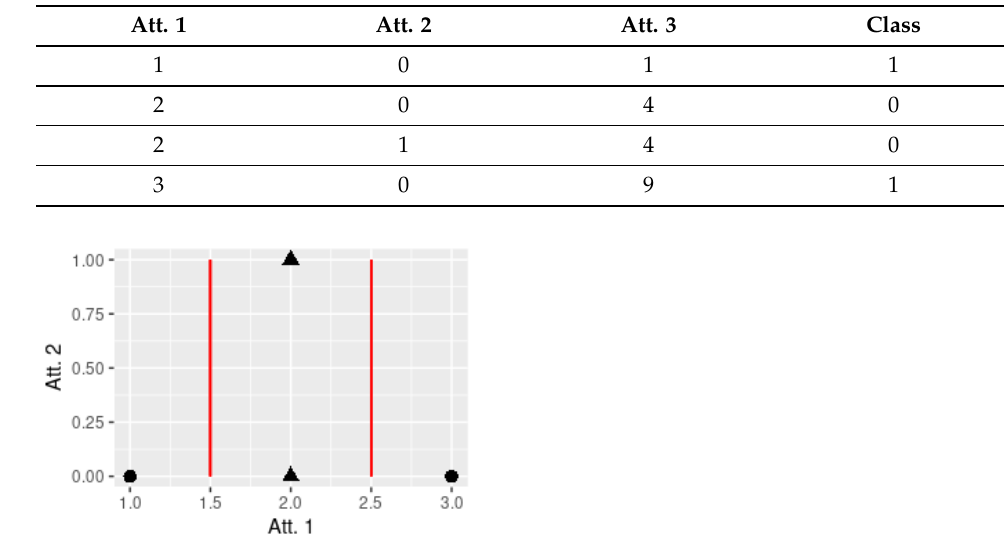
Table 2. Example of linear separability thanks to a new redundant feature.